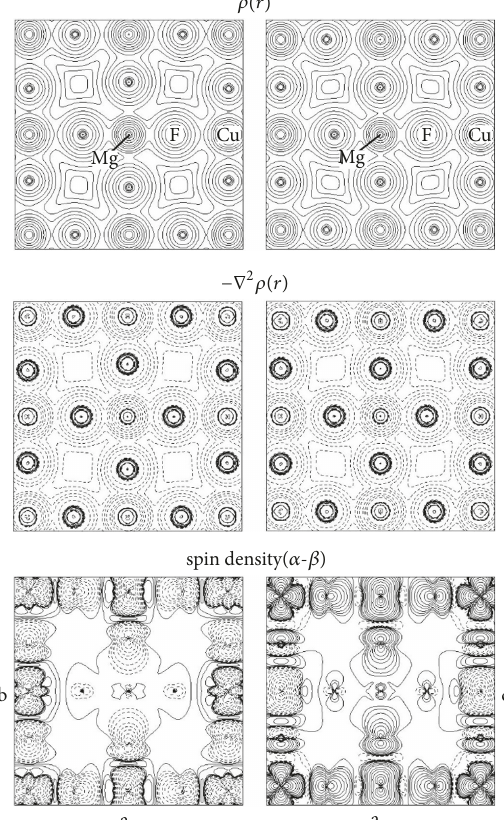
Figure 3: Contour plots of the electron density, the Laplacian of the electron density changed in sign and spin density in Mg-doped KCuF 3 .Leftpanelsrefertothe ab andtherightpanelstothe ac plane. Full and dashed lines indicate positive and negative values of the plotted function, respectively. Plots refer to the AF1 phase.